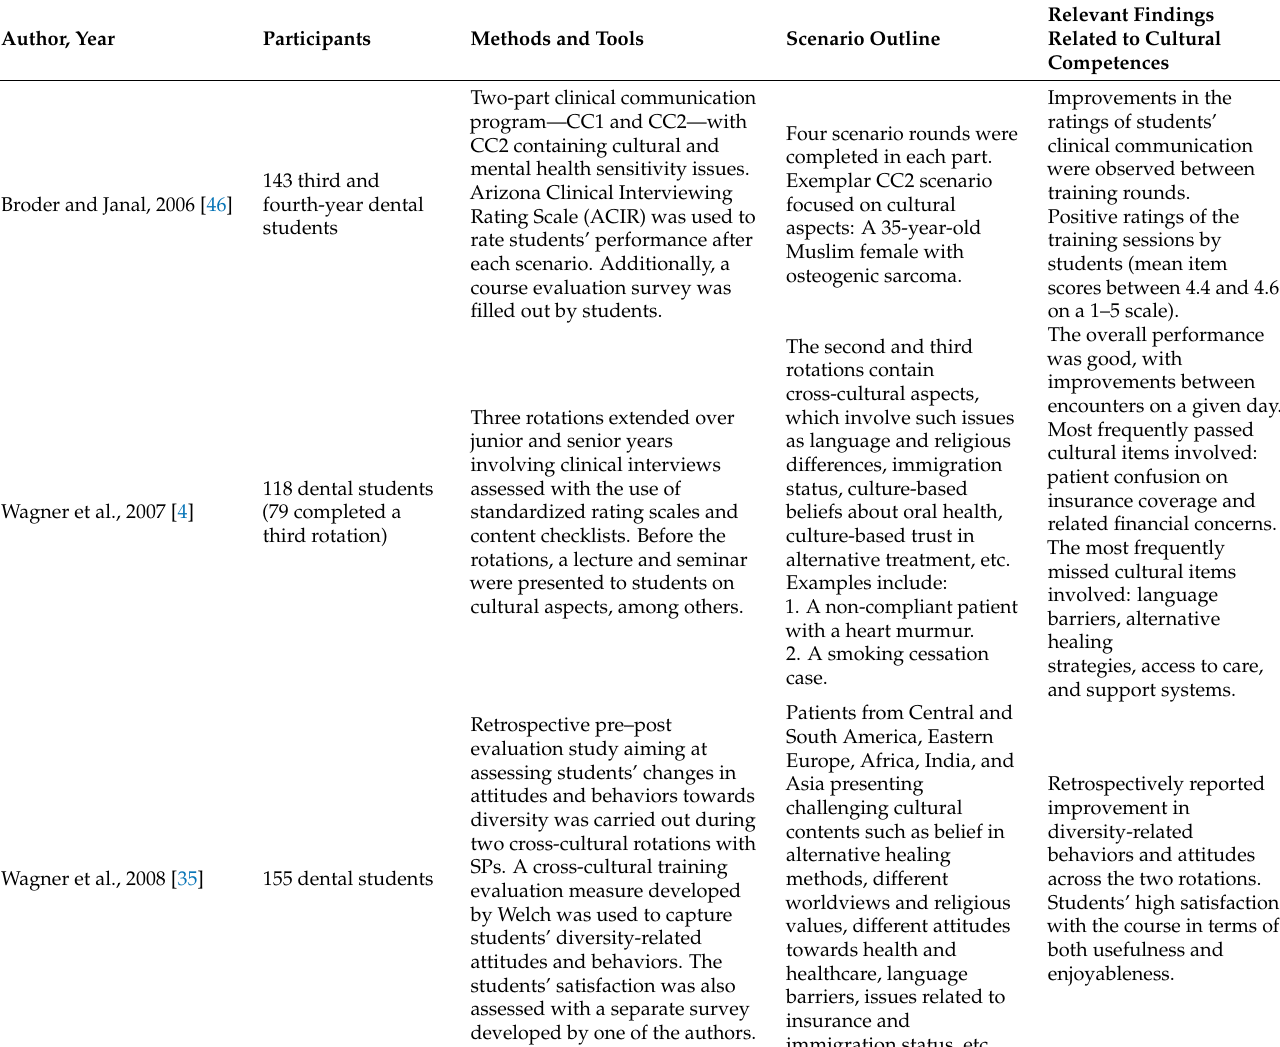
Table 4. Descriptive summary of studies on students of other